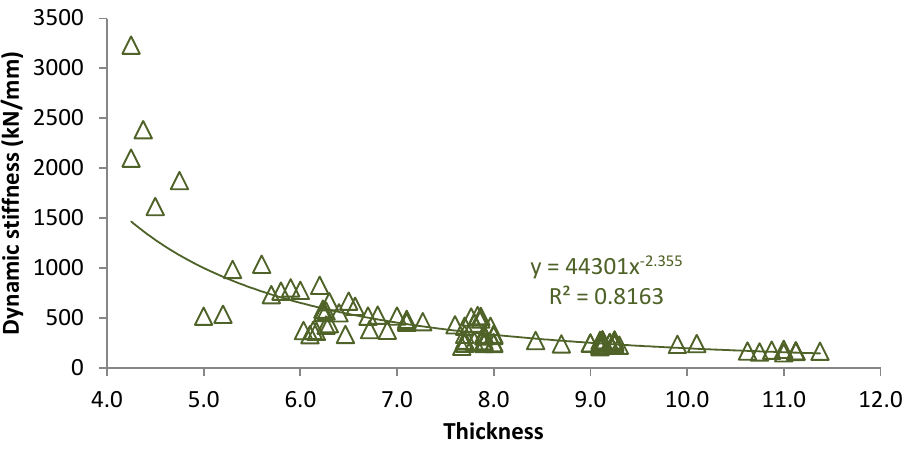
Figure 4. Dynamic stiffness for tire pads with diverse thickness